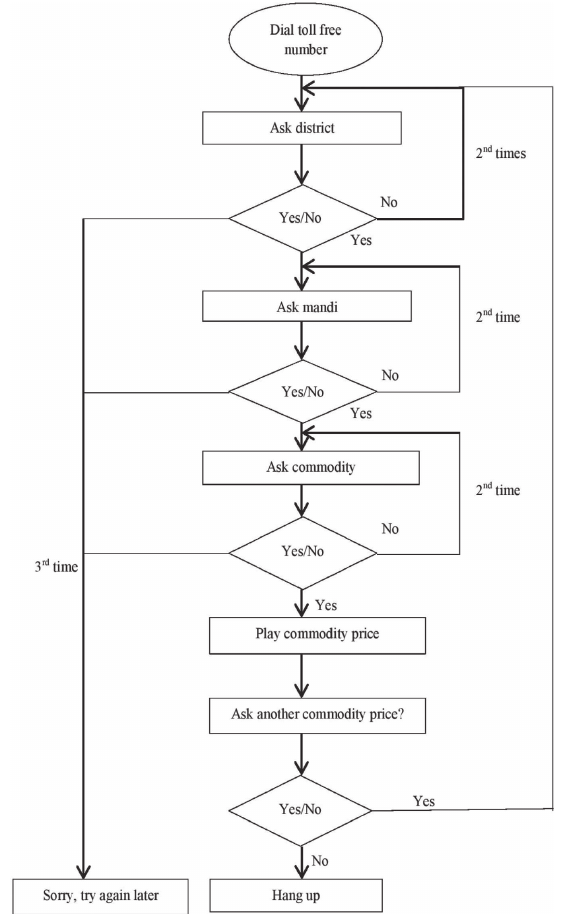
Figure 10: Call Flow Structure of Commodity Price Information Spoken Query System (Reproduced from Ref. [32] for Correct Flow of this Work).